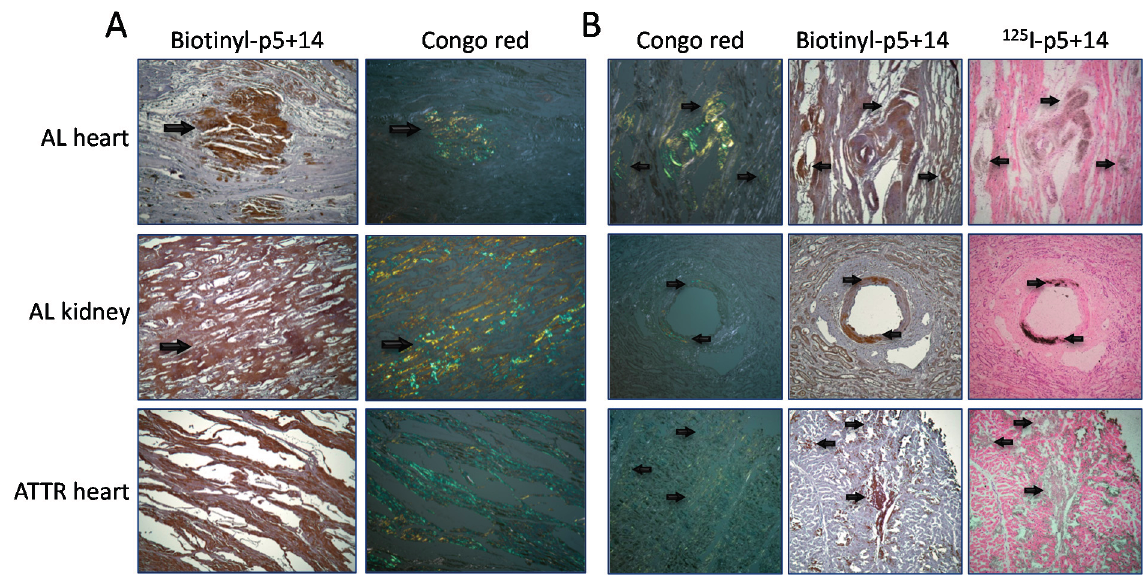
Figure 7. Peptide p5+14 specifically binds human AL and ATTR amyloid in tissue sections. ( A ) Biotinylated p5+14 (brown) stained human renal and cardiac AL, or cardiac ATTR amyloid seen as green-gold birefringence in Congo red-stained sections; ( B ) 125 I-p5+14 binding correlated with the distribution of amyloid in tissue sections seen using biotinylated p5+14 (brown) and Congo red birefringence (green gold). Arrows indicate the sites of amyloid in Congo red section and peptide p5+14